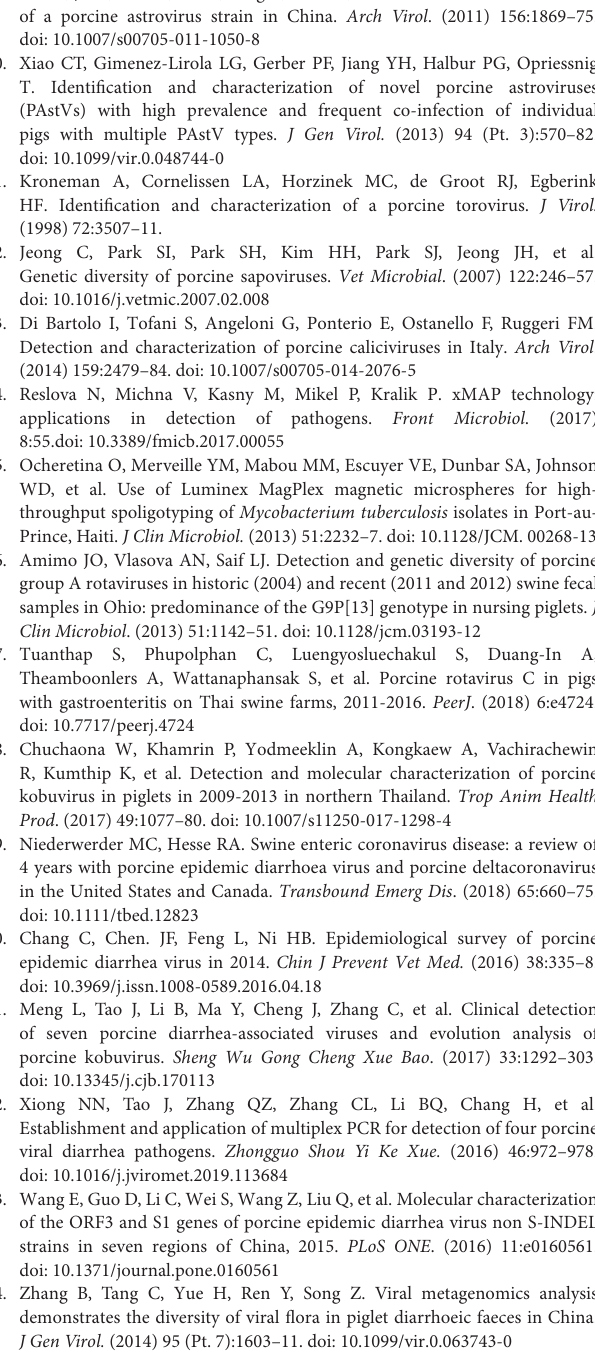
viruses. M: DL1000 DNA Marker; 1–5: 10 − 1 -10 − 5 fold dilution template, respectively; 6: negative control. (B) The sensitivity of traditional RT-PCR method for four kinds of diarrhea viruses. M: DL1000 DNA Marker; 1–7: 10 0 -10 − 5 fold dilution template, respectively; 8: negative control. (C) The sensitivity of the Luminex xTAG detection method for seven kinds of diarrhea viruses. (D) The sensitivity of the Luminex xTAG detection method for four kinds of diarrhea